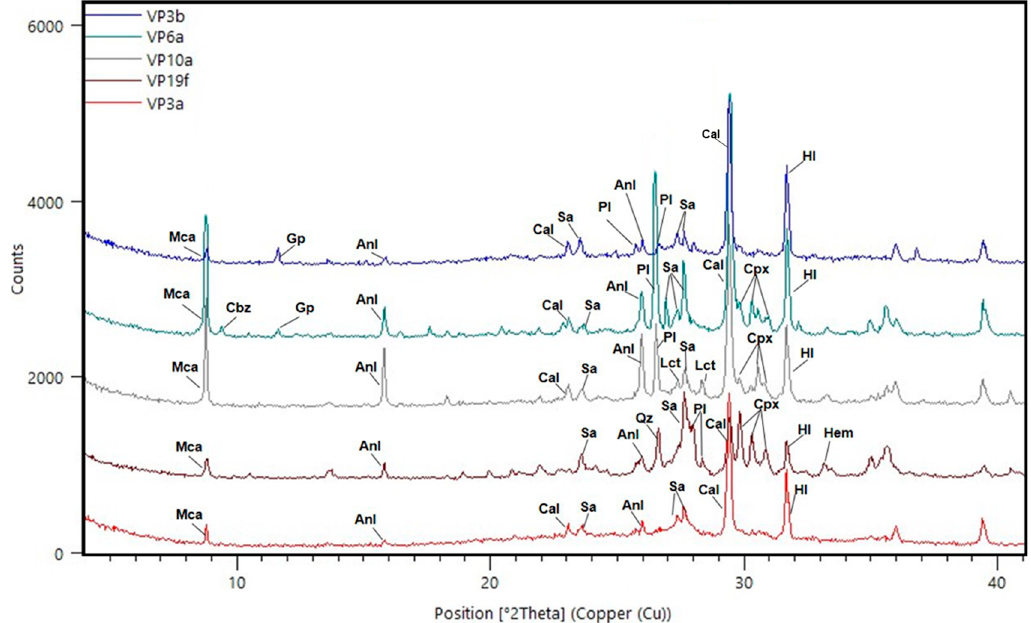
Figure 6. Qualitative mineralogical analysis of mortars. XRPD patterns of selected samples of mortars.